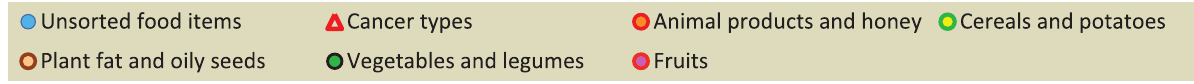
FigUre 7 | Factor analysis: a plot of Factor 1 and Factor 2 explaining 49.5% variability. For better clarity, only the main indicators of cancer incidence were selected (103 variables total). Abbreviations: NHL, non-Hodgkin lymphoma; % PC CARB energy, the proportion of energy from potato and cereal carbohydrates (as % of total energy intake); % CA energy, the proportion of energy from carbohydrates and alcoholic beverages (as % of total energy intake); Protein index, the ratio between milk and wheat proteins (an indicator of a high dietary protein